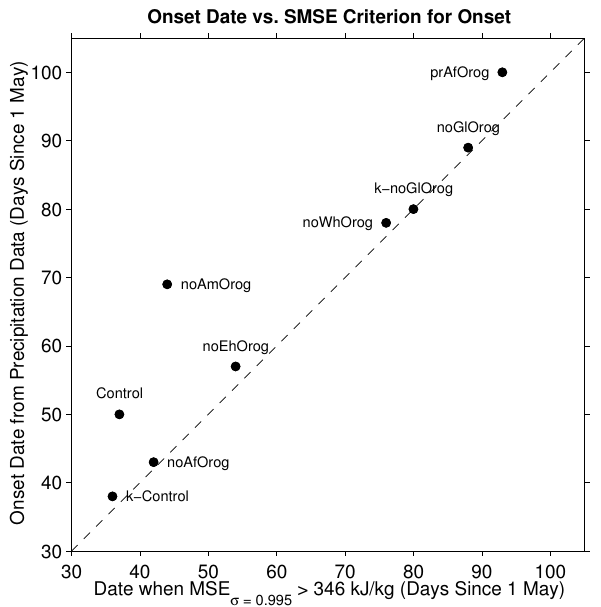
Fig. 17. Onset date vs. first necessary ( SMSE ) criterion for onset. Key words starting with k- indicates simulation with Kuo cumulus convection.